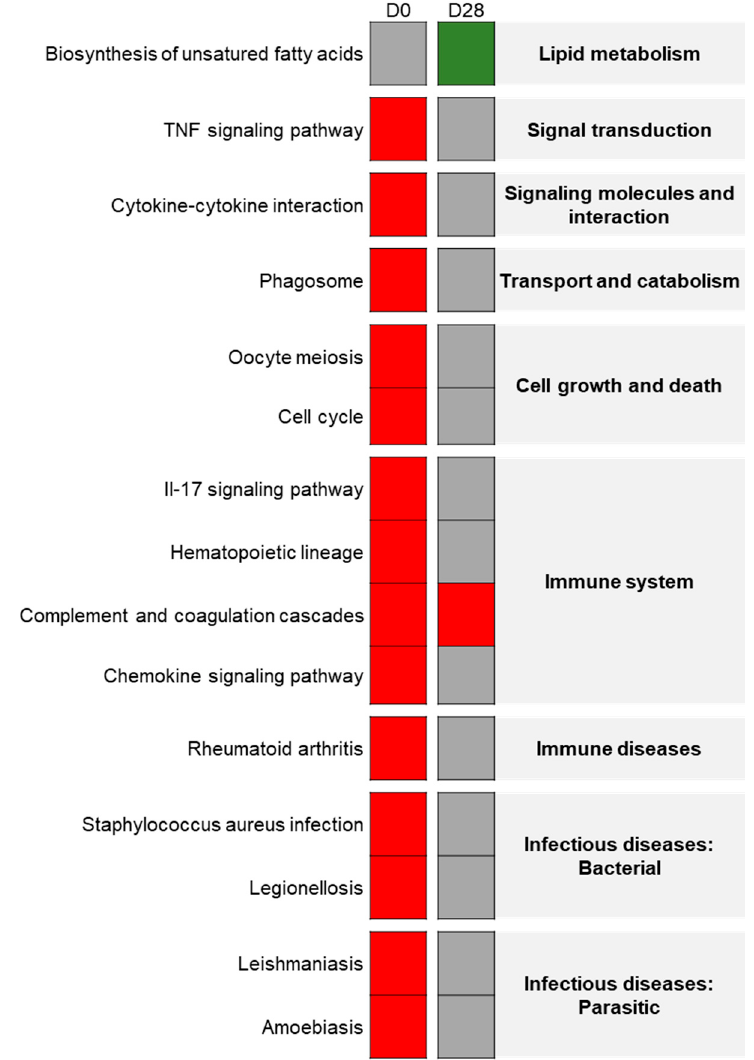
Figure 4. Exposure effect on young rats: Heatmap from the FunMappOne tool. The first column represents the data for day 0 (D0) and the second for day 28 (D28). The color of the boxes represents the level of expression of a majority of genes involved in this pathway: green for under-expression in exposed group compared to controls, red for over-expression, and grey for no difference.